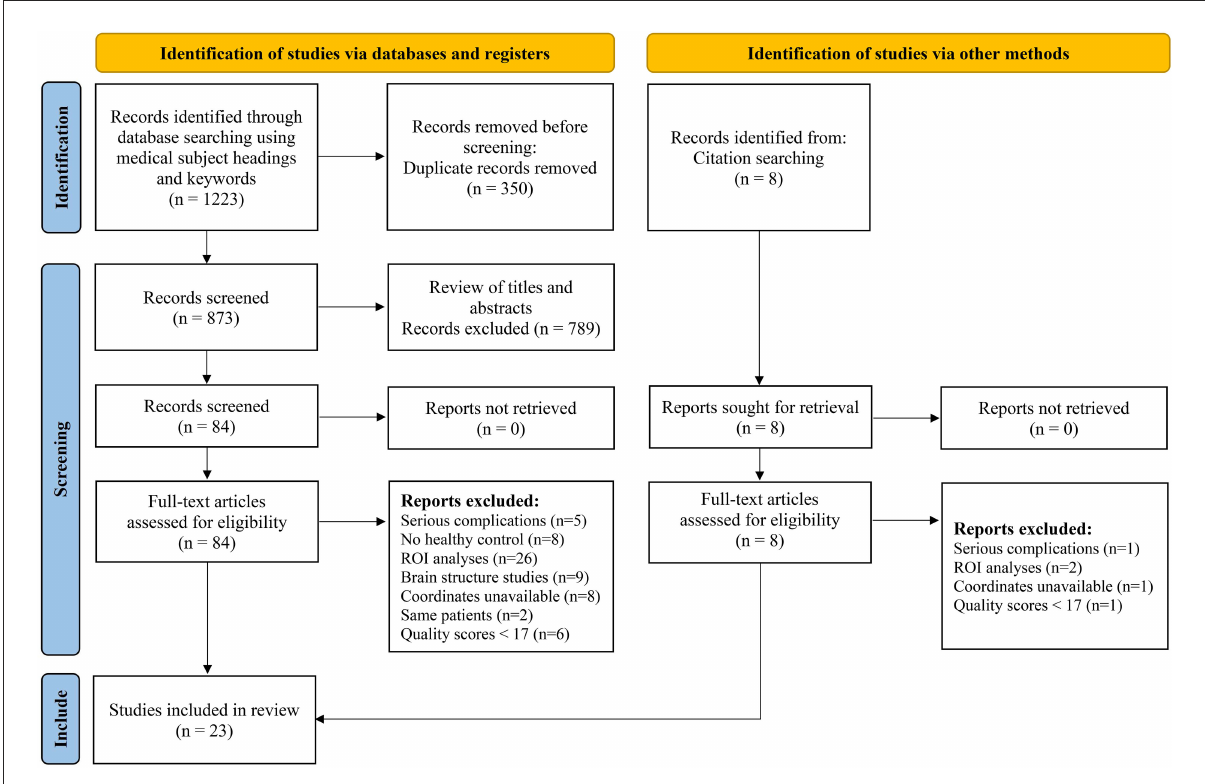
FIGURE1 Flowchart to identify the eligible studies for meta-analysis. ROI, region of